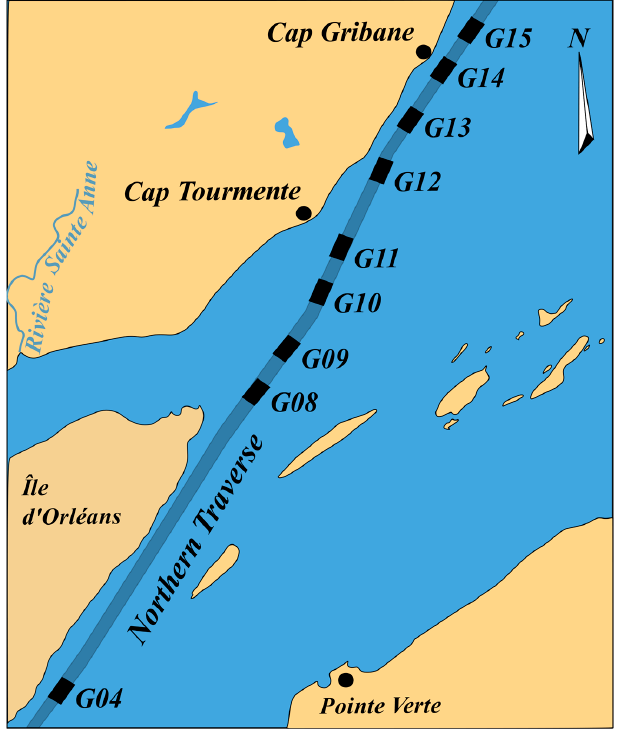
Figure 7. Studied sectors (e.g., G04, G08,…, G15) of the Northern Traverse of the Saint-Lawrence